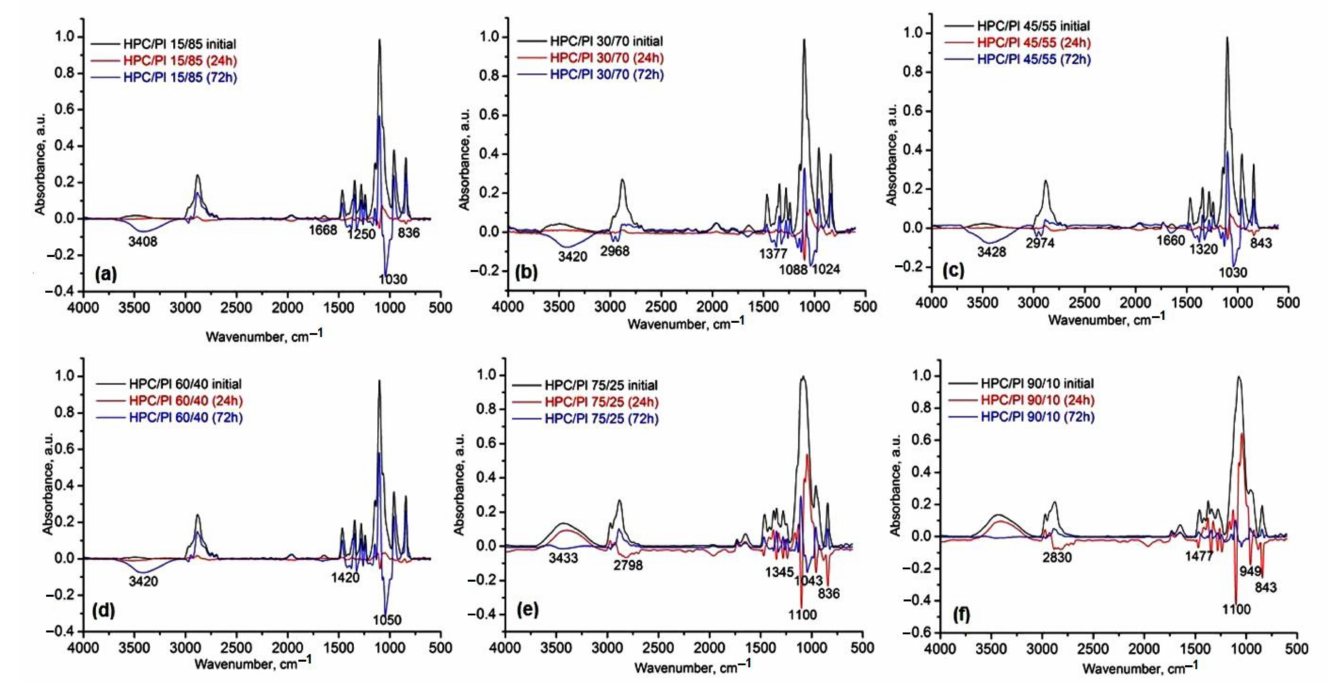
Figure 11. IR subtracted spectra before and after biodegradation of hydrogels in PBS medium at pH 7.4 for: ( a ) HPC/Pl 15/85, ( b ) HPC/Pl 30/70, ( c ) HPC/Pl 45/55, ( d ) HPC/Pl 60/40, ( e ) HPC/Pl 75/25, ( f ) HPC/Pl